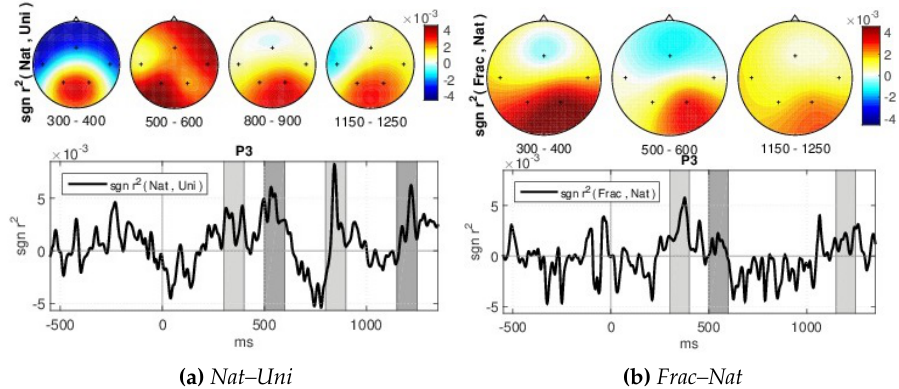
Figure 6. GA signed r 2 over all blocks for: a) Nat-Uni and b) Frac-Nat discriminations at P3 channel.